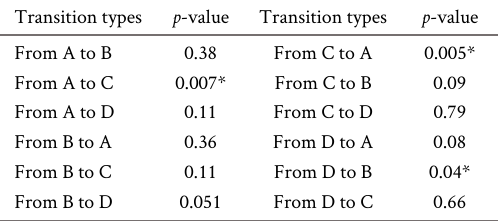
Table 3. Statistical results of microstate transition rate between patients with LLA and HC